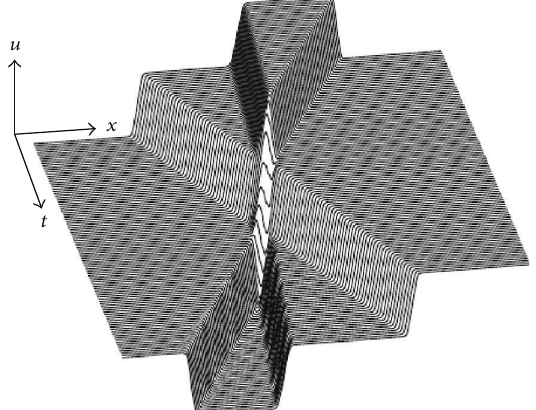
Figure 6: Evolution of the antikink-antikink-kink triplet, 𝑉 1 > 0 , 𝑉